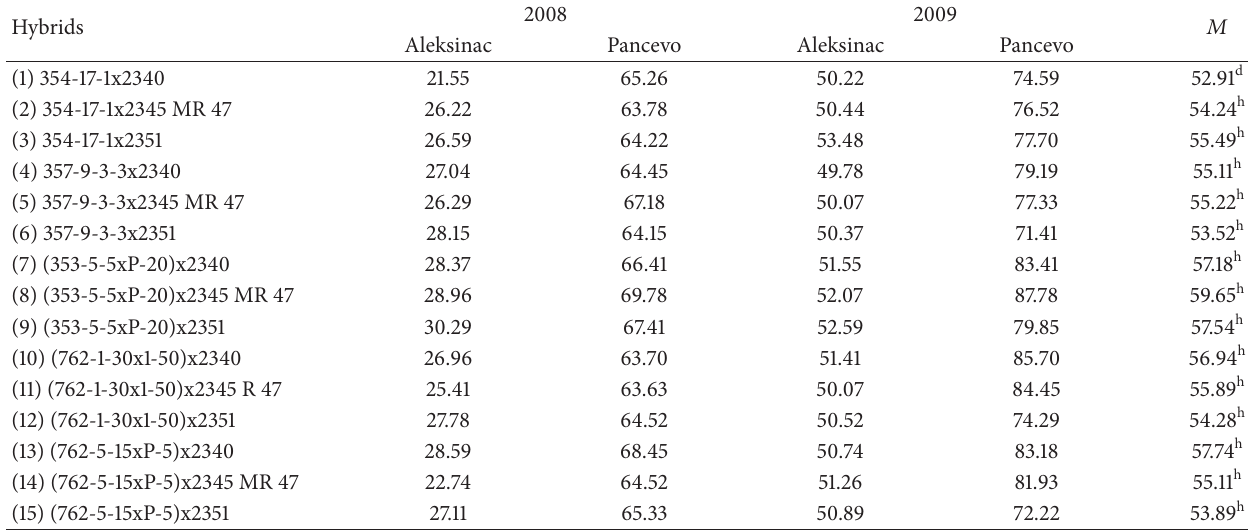
Table 2: Mean values and the mode of inheritance of root yield (tha − 1 ) in hybrids. Hybrids